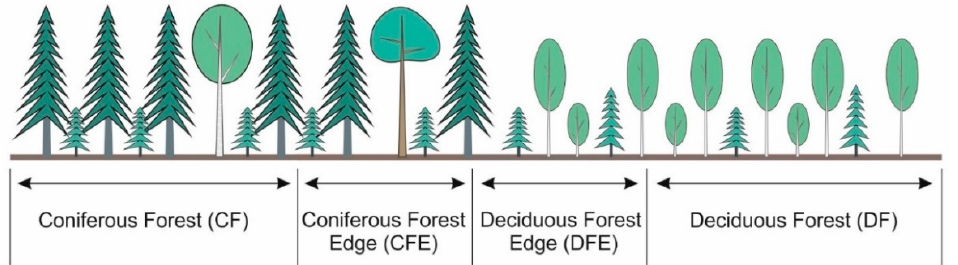
Figure 3. Chart of the ecotone between bilberry-type spruce forest and the deciduous stand formed after clear-cutting.